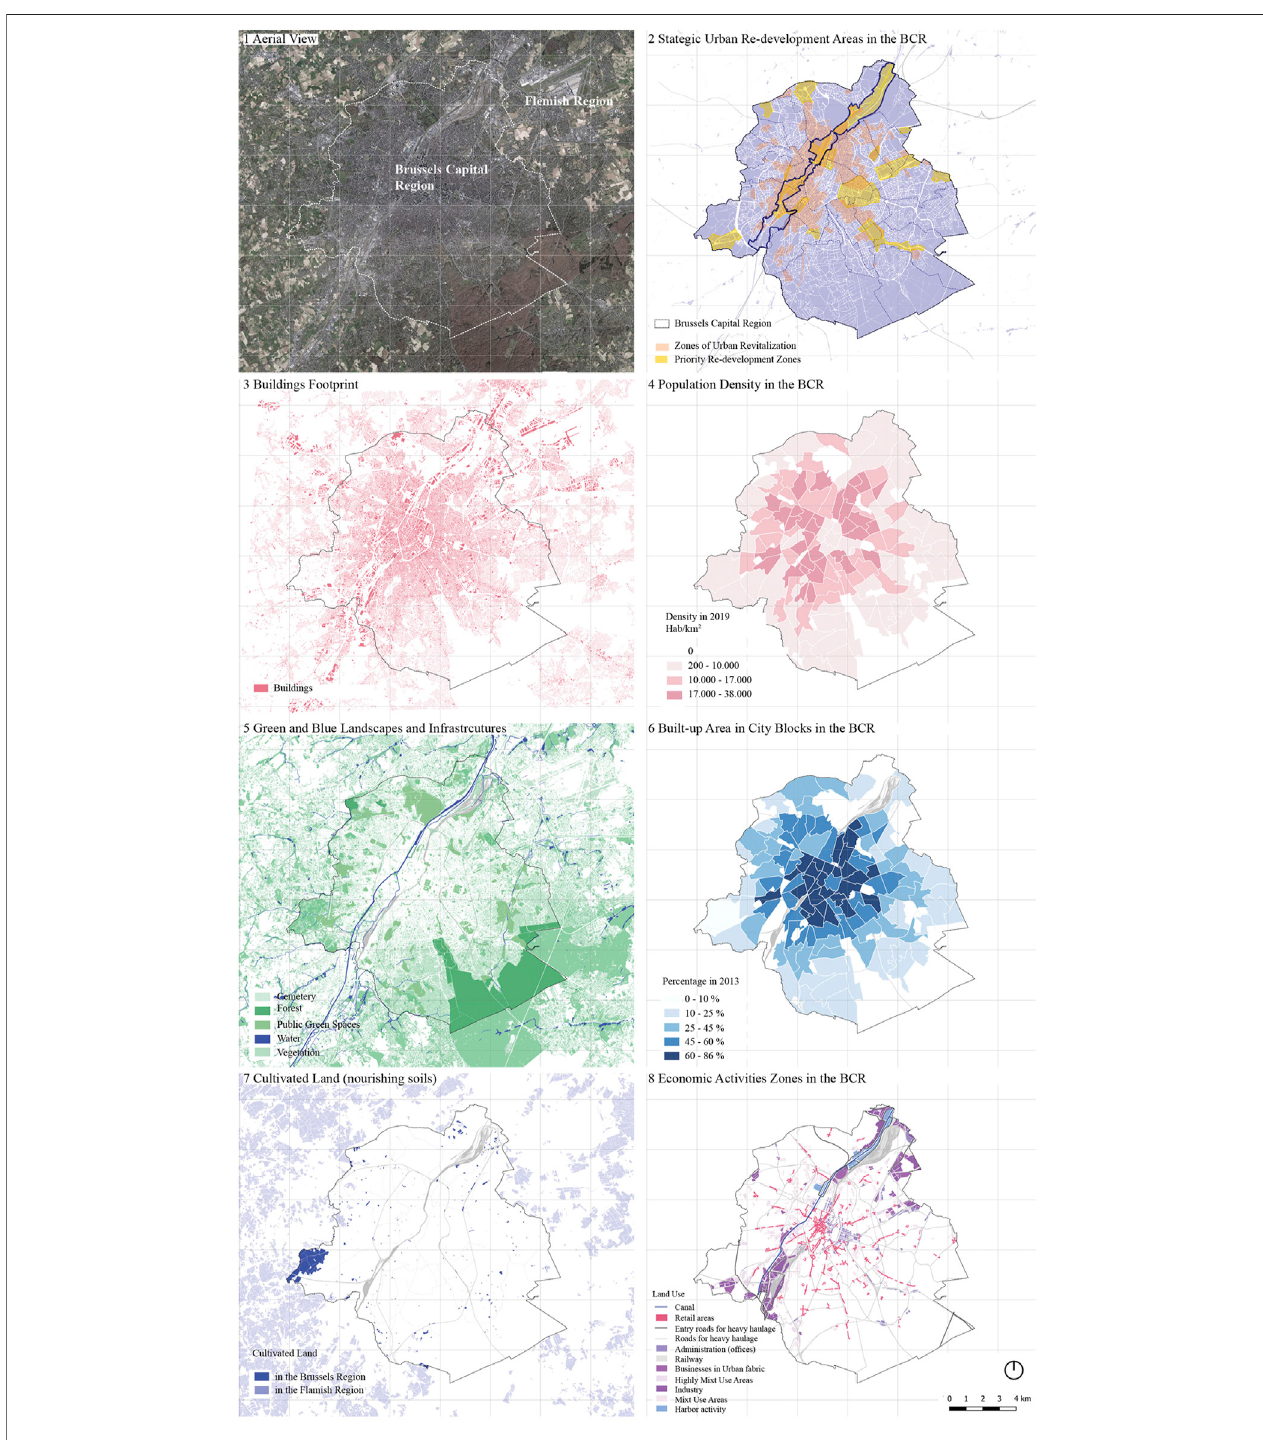
FIGURE 2 | Brussels Capital Region territorial fi gures, by the authors.